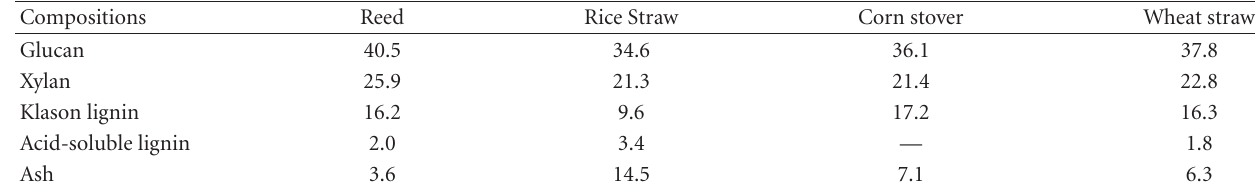
Table 1: Chemical compositions of reed and other biomass sources (%, by dry weight).